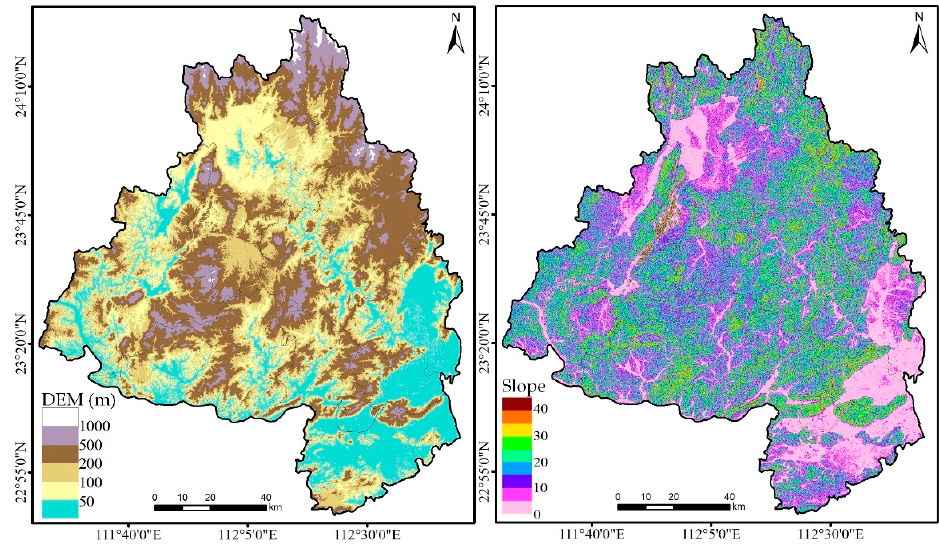
Figure 2. Topographic map of Zhaoqing city.